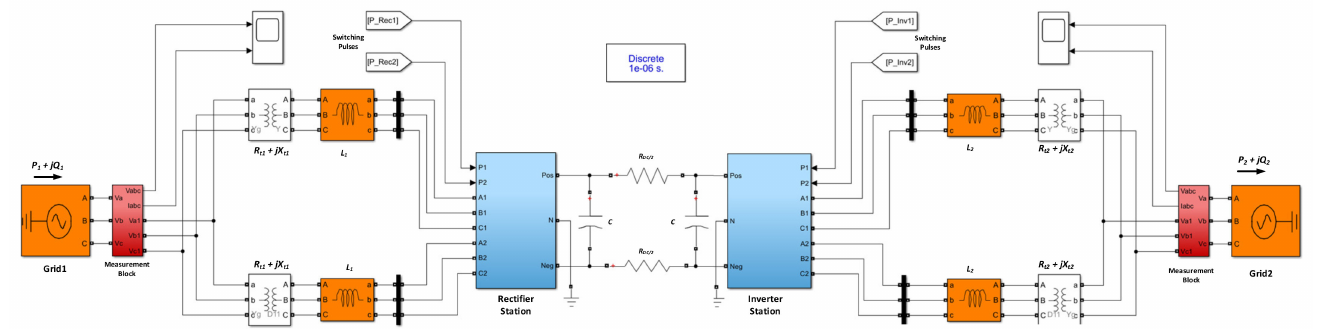
Figure 12. MATLAB/Simulink model of VSC HVDC system.